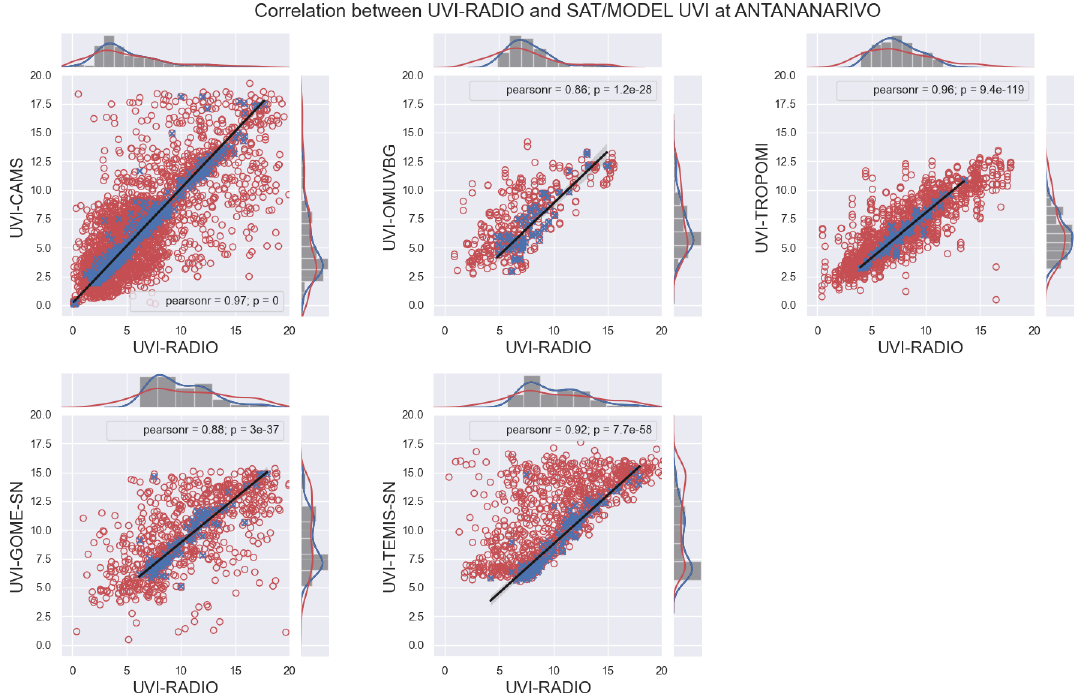
Figure A3. Correlation between UVI-RADIO and satellite/model estimates at Antananarivo. A histogram representing each dataset dis- tribution is represented at the right and at the top side of each subfigure. The clear-sky measurements made by UVI-RADIO have been distinguished and are shown as blue crosses, while the measurements for all-sky conditions are shown as red circles.